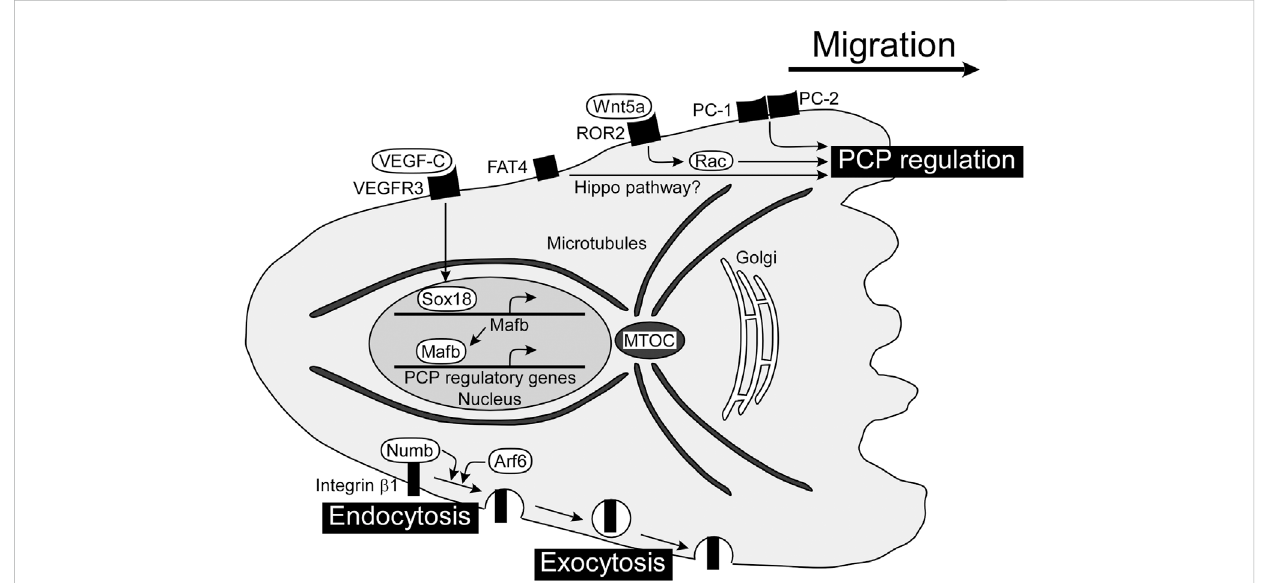
FIGURE 2 PCP regulators for directed migration of LECs and formation of tubular lymphatic vessels. PCP is established in a migrating cell with the localization of the MTOC and Golgi apparatus in front of the nucleus. There are several players regulating PCP in LECs, including Wnt5a, PCs, and FAT4, although the mechanisms of molecular interactions are not clear yet. VEGF-C/VEGFR3-dependent expression of Mafb induces gene expression involved in PCP regulation. The internalization and transport of integrin β 1 towards the cell front enhance the establishment of front-rear polarity. FAT4, FAT tumor suppressor homolog 4; LEC, lymphatic endothelial cell; Mafb, MAF bZIP transcription factor B; MTOC, microtubule-organizing center; PC, polycystin; PCP, planar cell polarity; VEGF-C, vascular endothelial growth factor C; VEGFR3, vascular endothelial growth factor receptor 3; Wnt5a, wingless-type MMTV integration site family member